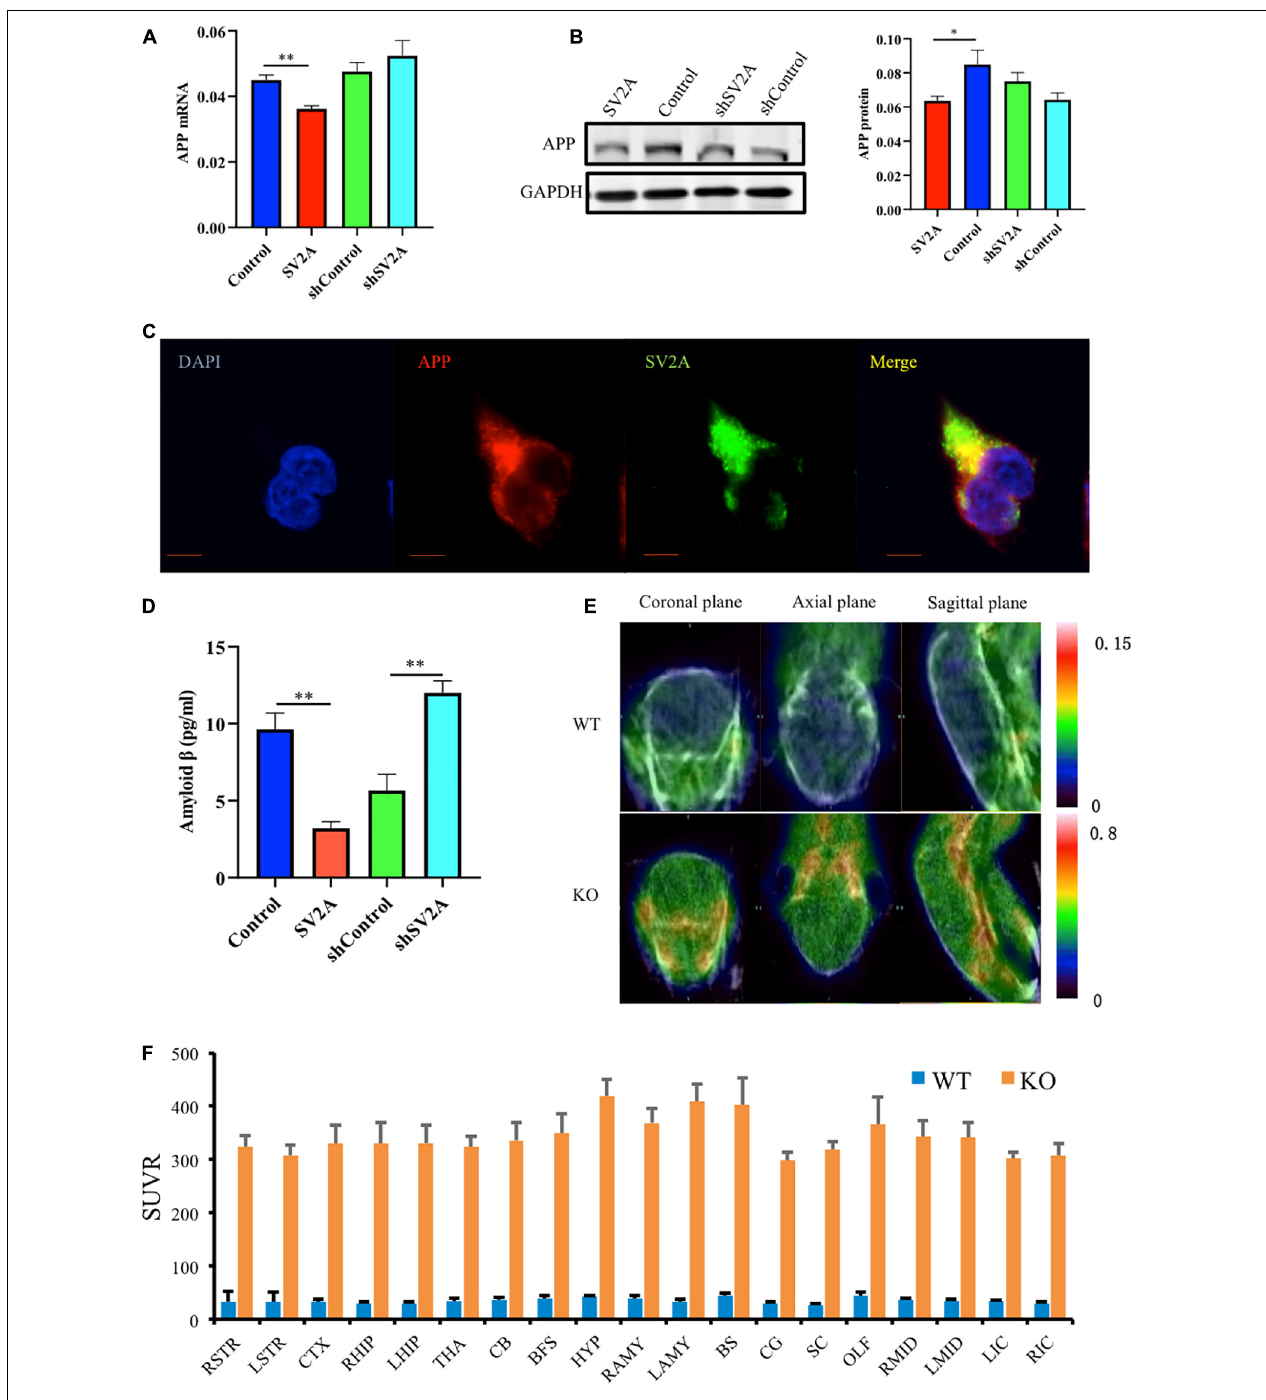
FIGURE 2 | SV2A regulates the expression level of APP. (A) qPCR detection of APP mRNA expression level in APPswe293T cells from the following four groups: control, cells infected with the SV2A-overexpressing virus (SV2A), shControl, and cells infected with the SV2A-silencing virus (shSV2A). Gapdh was used as the internal control. (B) Western blotting detection of APP expression levels in APPswe293T cells from the following four groups: control, cells infected with the SV2A-overexpressing virus (SV2A), shControl, and cells infected with the SV2A-silencing virus (shSV2A). The gray density was normalized to the mean gray density of Gapdh. (C) Immunofluorescence observation of the APP (red) and SV2A (green) in APPswe293T cells. The nuclei were counterstained with DAPI (blue). Scale bar, 40 µ m. (D) Statistical analysis of ELISA detection of the expression of A β secreted from APPswe293T cells from the following four groups: control, cells infected with the SV2A-overexpressing virus (SV2A), shControl, and cells infected with the SV2A-silencing virus (shSV2A). (E) 18 F-AV45 PET was used to trace A β in WT and SV2A-KO mice. (F) The 18 F-AV45 SUVR of different brain regions in WT and SV2A-KO mice using PMOD analysis. For each group of APPswe293T cells, n = 3. Data are expressed as mean ± SEM. One-way analysis of variance (ANOVA). ∗ p < 0.05. ∗∗ p < 0.01.